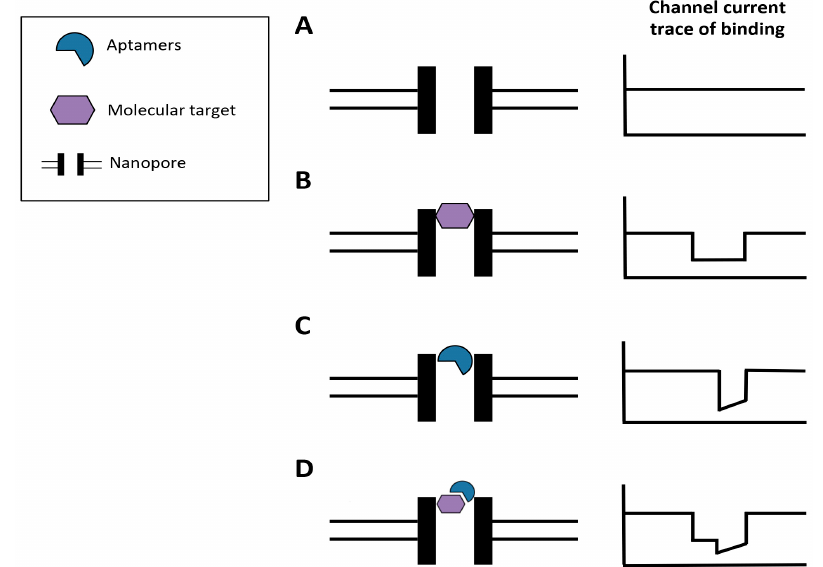
Figure 5. Flowchart of nanopore-based aptamer assaying. Nanopore sensors can be used to detect aptamer binding and selection in a real-time. Aptamer and target interaction can be detected by measuring the current disruption caused by molecules electrophoretically driven through the pore.